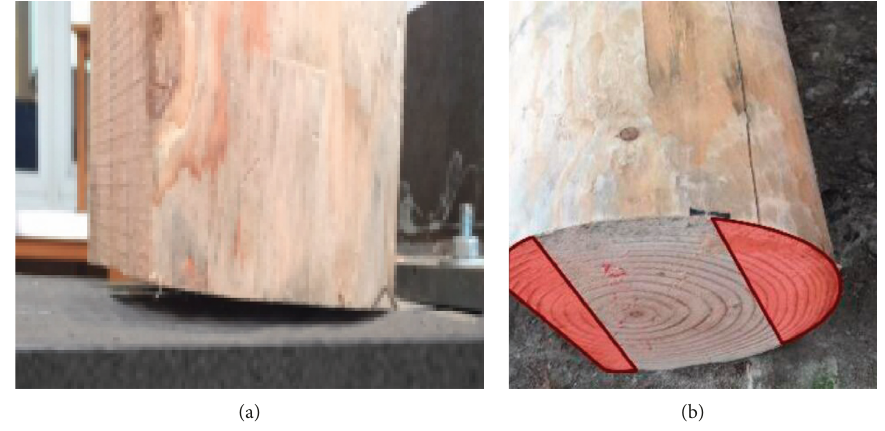
Figure 7: Column foot behaviour in wood frame ZJJ40. (a) Uplift. (b) Edges with compression deformation.